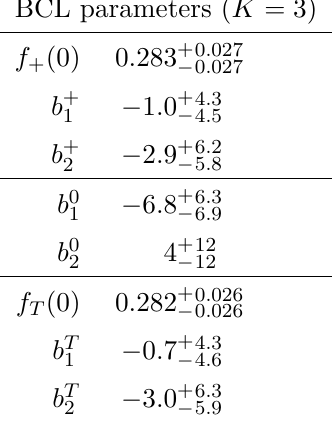
The median values and central 68% probability intervals obtained from the one-dimensional marginalized posterior distributions for the parameters of the common BCL parametrization eq. (3.4) for the K = 3 fit when fitted to the LCSR pseudo data points. The total χ 2 is 0 . 017 for 6 degrees of freedom, corresponding to a p value in excess of 99% at the best- fit